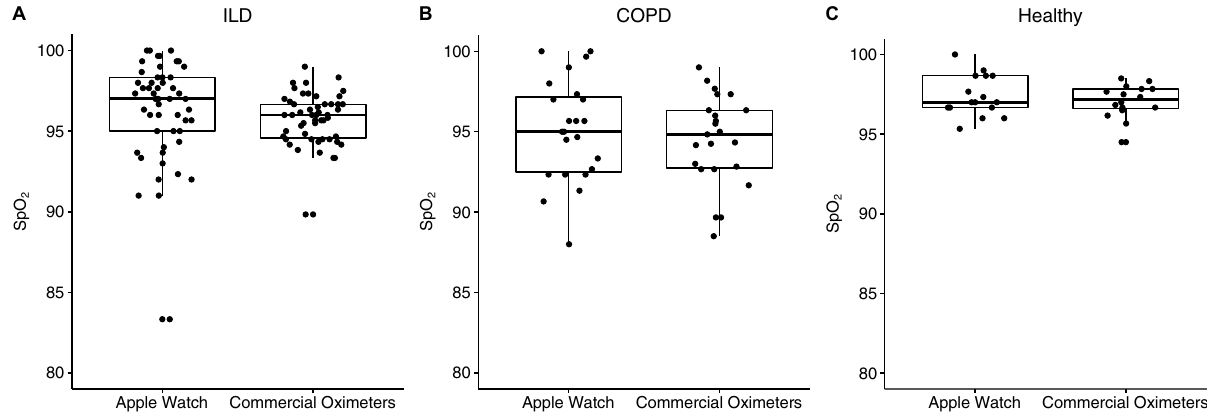
Figure 4. Comparison of Apple Watch and commercial oximeters devices of SpO 2 . ( A ) Interstitial Lung Disease (ILD), ( B ) Chronic Obstructive Pulmonary Disease (COPD) and ( C ) Healthy